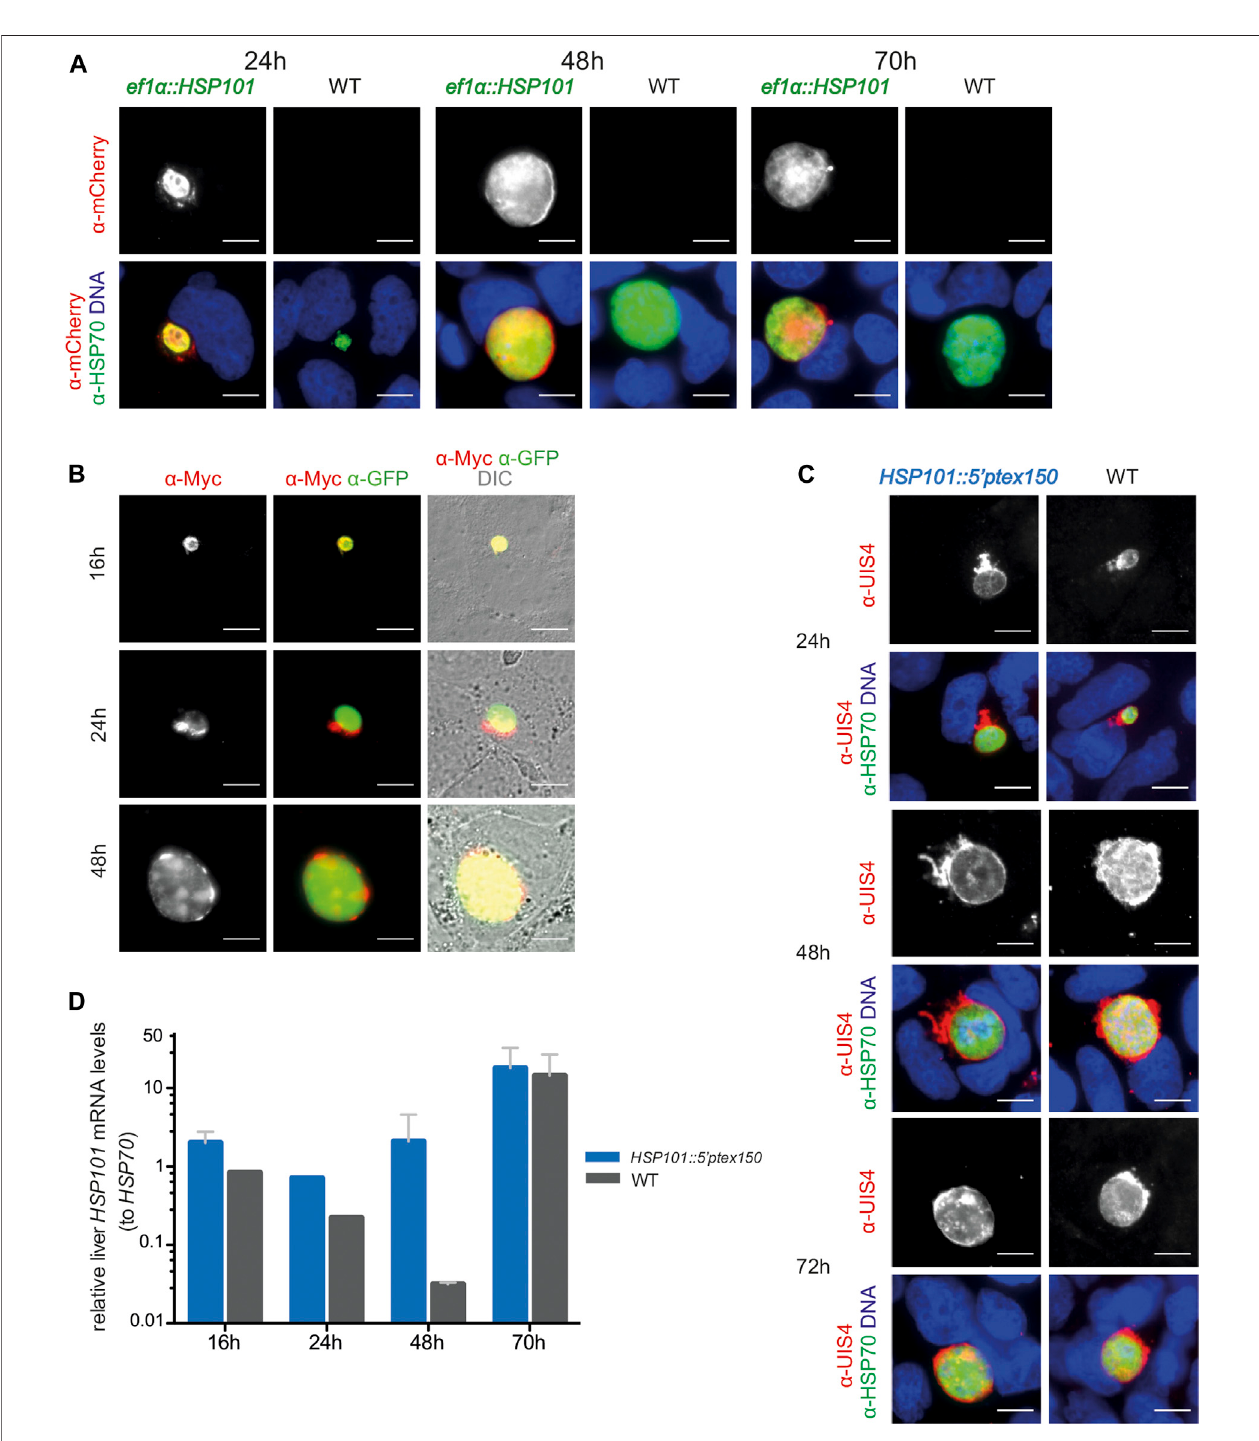
FIGURE 3 | Ectopic expression of HSP101 in liver stages results in PV localization. (A) Localization of HSP101-mCherry in ef1 α :HSP101-mCherry -infected hepatoma cells at 24, 48, and 72 h after infection. Shown are immuno fl uorescent images with α -mCherry antibody (top row) and merge images (bottom row) displaying the signals of α -mCherry (red), α -HSP70 (green), and Hoechst 33,342 (blue). Bars, 10 µm. (B) Localization of HSP101-myc in ef1 α :HSP101-myc -infected hepatoma cells at 16, 24, 48 h after infection. Shown are immuno fl uorescent images with an α -myc antibody (left column) , α -myc (red) and α -GFP (green) antibodies (centercolumn) ,andmergeimages (rightcolumn) displayingthesignalsof α -myc(red), α -GFP(green),andDIC.Bars,10 µm. (C) Liverstagedevelopment of hsp101:5 ′ ptex150 parasites at 24, 48, and 72 h after infection. Shown are immuno fl uorescent images with an α -UIS4 antibody (top) , and merge images (bottom) displaying the signals of α -UIS4 (red), α -HSP70 (green), and Hoechst 33,342 (blue). Bars, 10 µm. (D) Steady state HSP101 mRNA levels in hsp101:5 ′ ptex150 liver stages. Shown are relative mRNA levels determined qRT-PCR from total RNA of hsp101:5 ′ ptex150 or WT-infected hepatoma cells at indicated time points after infection. ΔΔ CT values of HSP101 mRNA values were normalized to HSP70 . Depicted are mean values ( ± SD) (n (cid:1) 2, except for 24h, n (cid:1) 1).